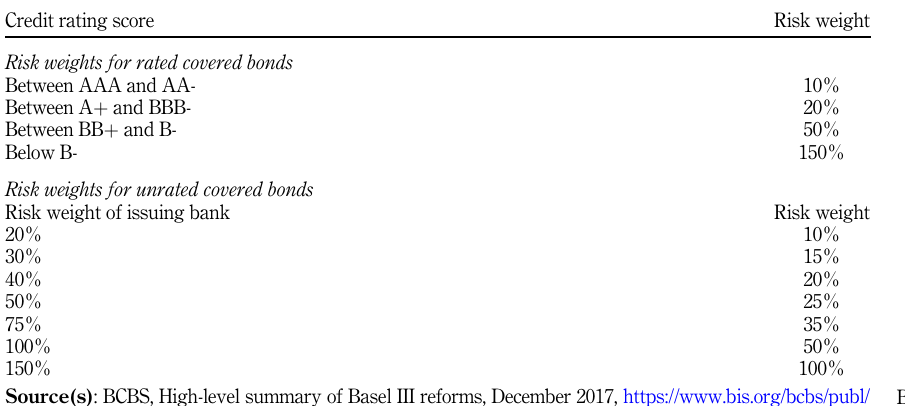
Table 6. Basel IV risk weights for covered